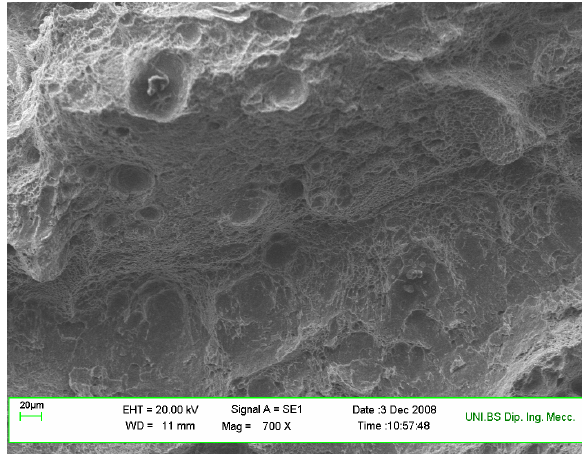
Figure 6. Fracture surface of the sample subjected to step cooling treatment and tested at − 40 °C.